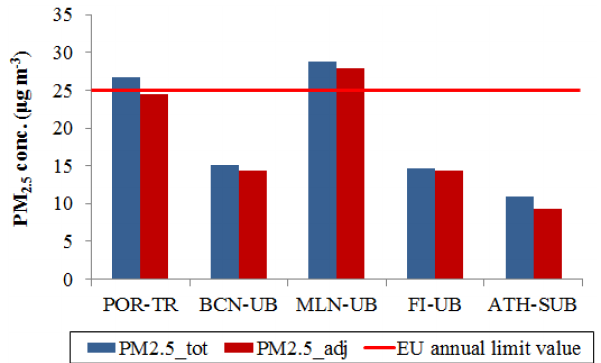
Figure 3. Annual mean of PM 2 . 5 concentrations (PM2.5_tot) and the respective adjusted concentrations after subtracting the contri- bution of natural sources (PM2.5_adj), for the AIRUSE sites. Red lines denote the annual limit value (25µgm − 3 ) for PM 2 . 5 set by the EU (Directive